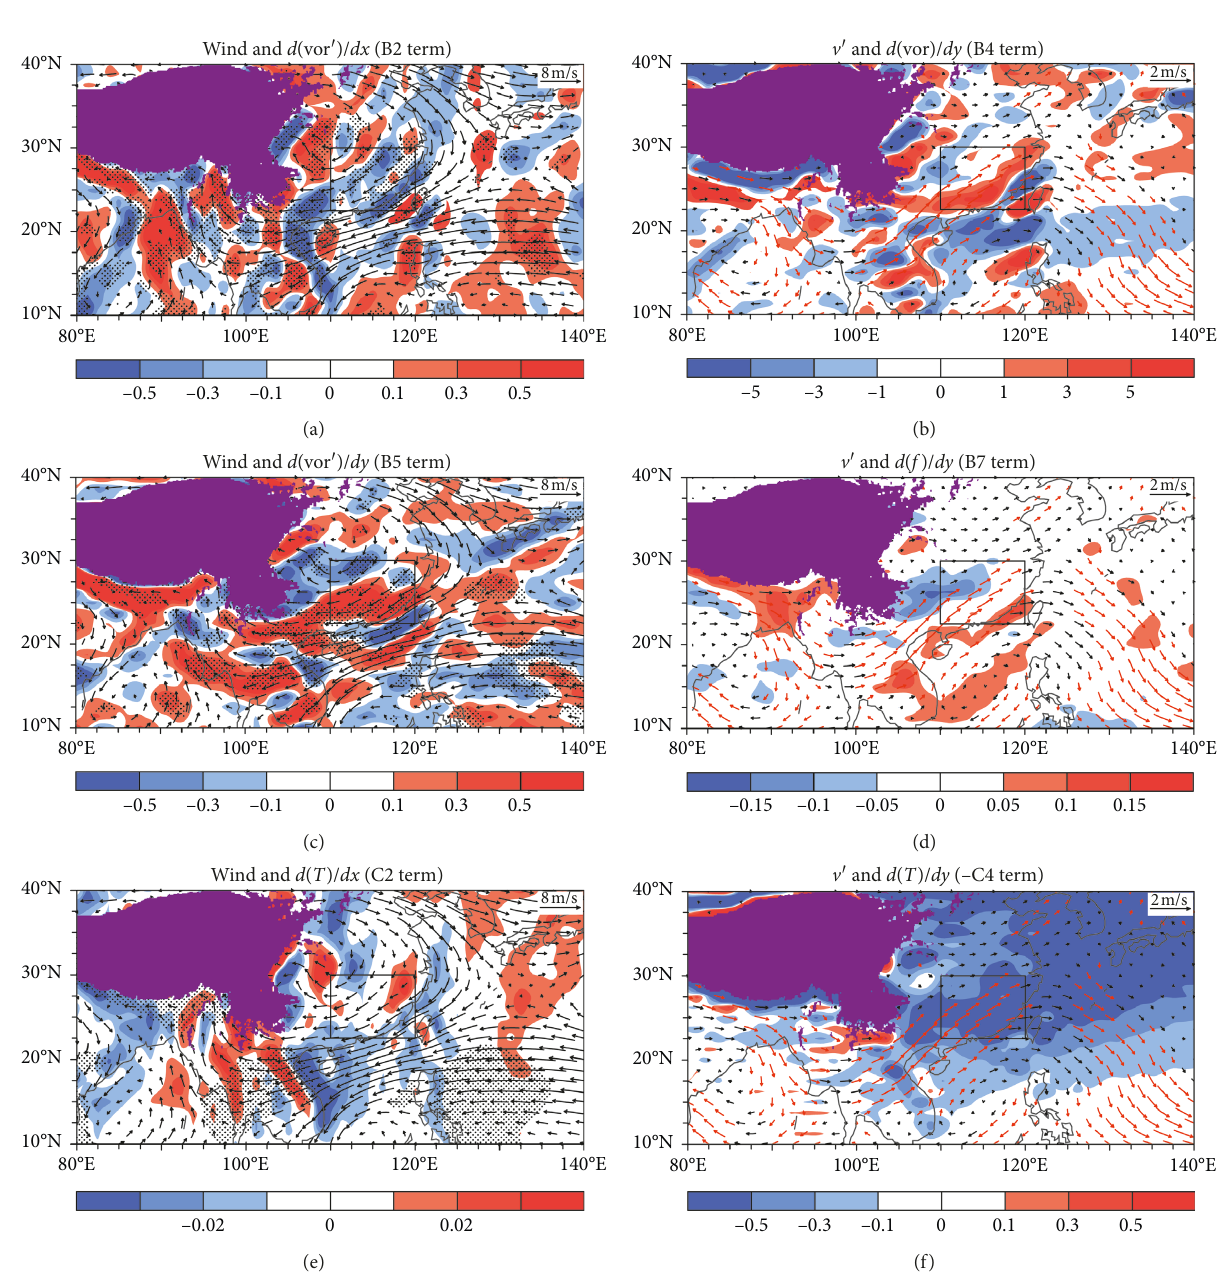
Figure 7: The diagnosis of B 2 (a), B 4 (b), B 5 (c), B 7 (d), C 2 (e), and C 4 (f) related to the Nino 3 index: (a) anomalous relative